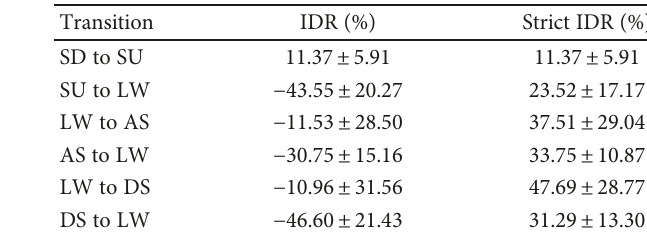
Table 3: IDR of transitions between locomotion